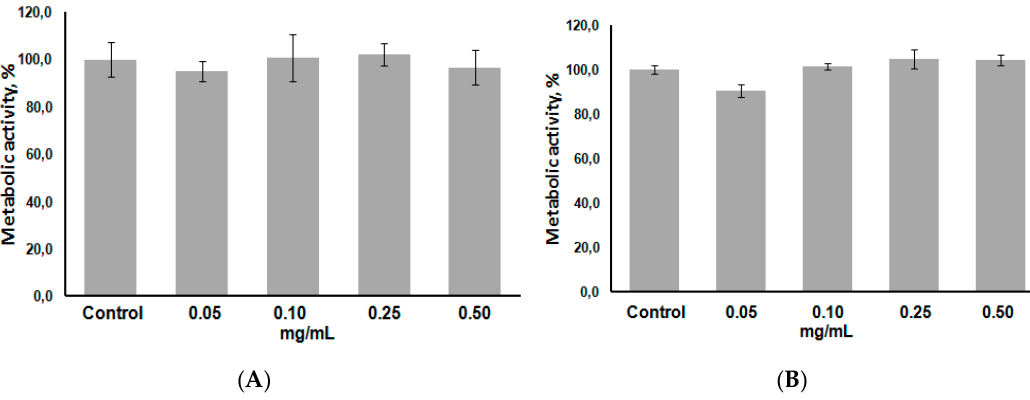
Figure 10. Viability of HEK ( A ) and Caco-2 ( B ) cells cultured in medium containing different concentrations of GP3 polymersomes.